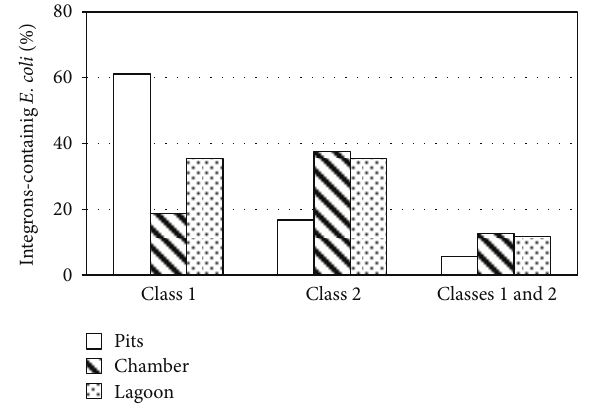
Figure 4: Percentages of E. coli integron positive isolates in pits production rooms for pigs, treatment chamber, and waste treatment lagoon in pig